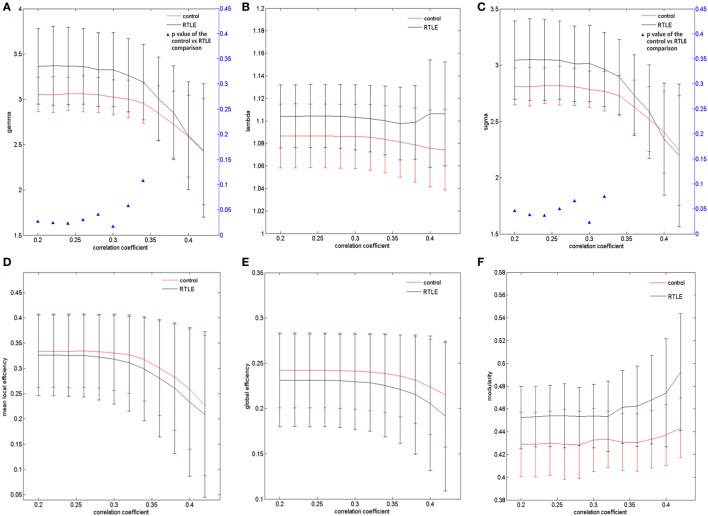
Structural connectivity network at different FA threshold for right temporal lobe epilepsy (rTLE) patients (the black line) and controls (the red line) and their statistical comparison results (ANCOVA). (A) Gamma, (B) lambda, (C) sigma, (D) mean local efficiency, (E) global efficiency, (F) modularity. Error bars indicate standard error within each group at each threshold value. The blue triangles display the (ANCOVA) p-values.